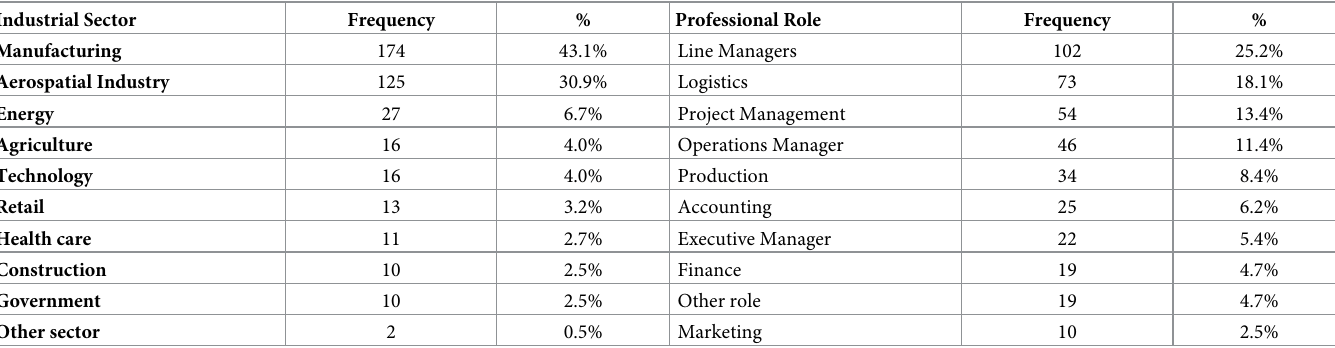
Table 2. Respondents by sector and professional